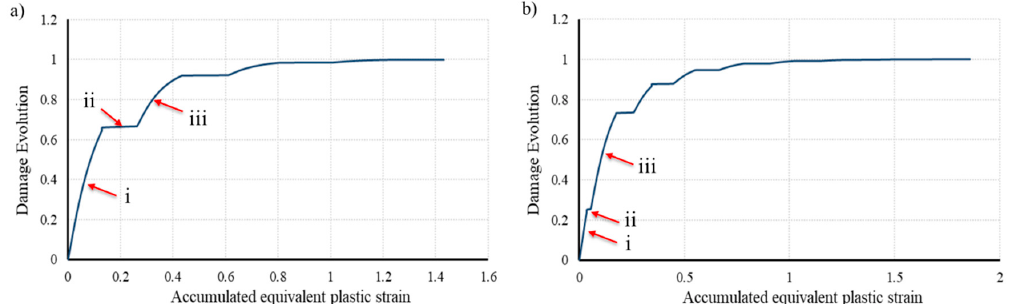
Figure 10. Damage accumulation for “R1” specimens under ELCF. ( a ) Damage accumulation for four ( N (cid:2916) (cid:3404) 4(cid:4667) and ( b ) nine ( N (cid:2916) (cid:3404) 9 ) high ‐ strain reversed cycles.